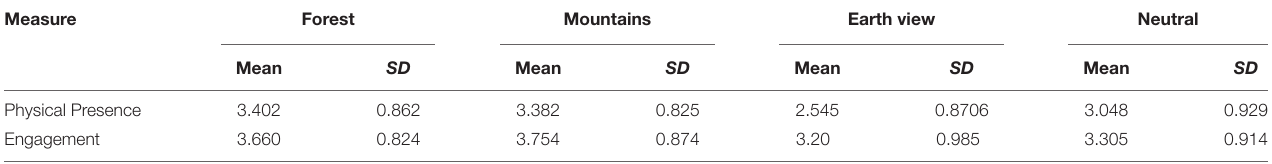
TABLE 3 | Physical presence and engagement scores for each condition: Mean and standard deviation for each condition. Measure